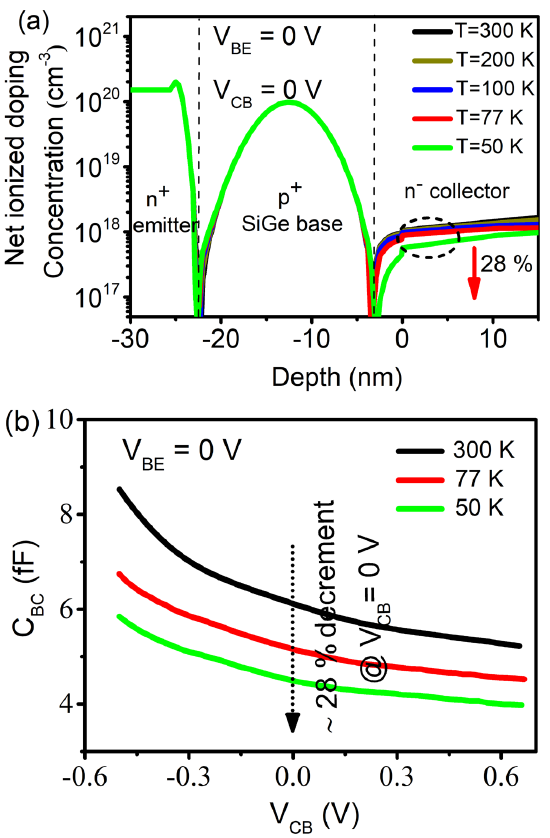
Figure 5. ( a ) Dopant incomplete ionization increases (net ionized doping concentration reduces) in the lightly doped (<N M ) intrinsic collector region with decreasing temperatures; ( b ) collector − base depletion capacitance (C BC ) in the lightly doped collector region decreased with an equivalent amount of decrease in doping concentration at V BE = V CB = 0 V under cryogenic